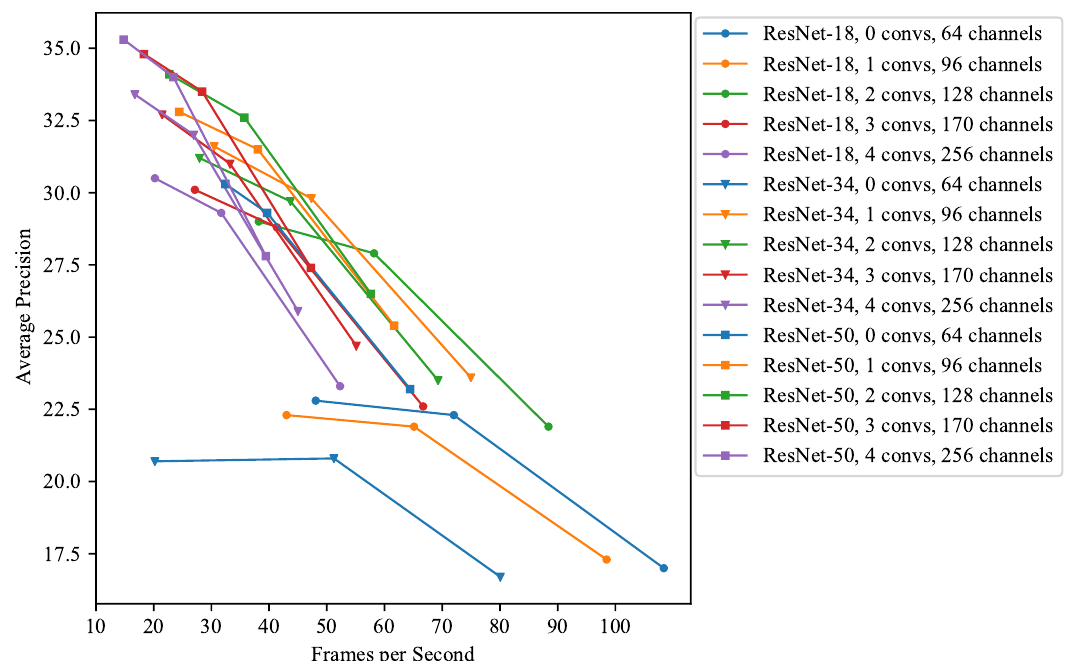
Figure A1. Comparing RetinaNet in different configurations with different input resolutions. Convs are the number of stacked convolutions in the head. Channels are the number of channels in the head and in the neck. The left point of each series is 800 × 800, the middle point is 600 × 600 and the right point is 400 × 400.